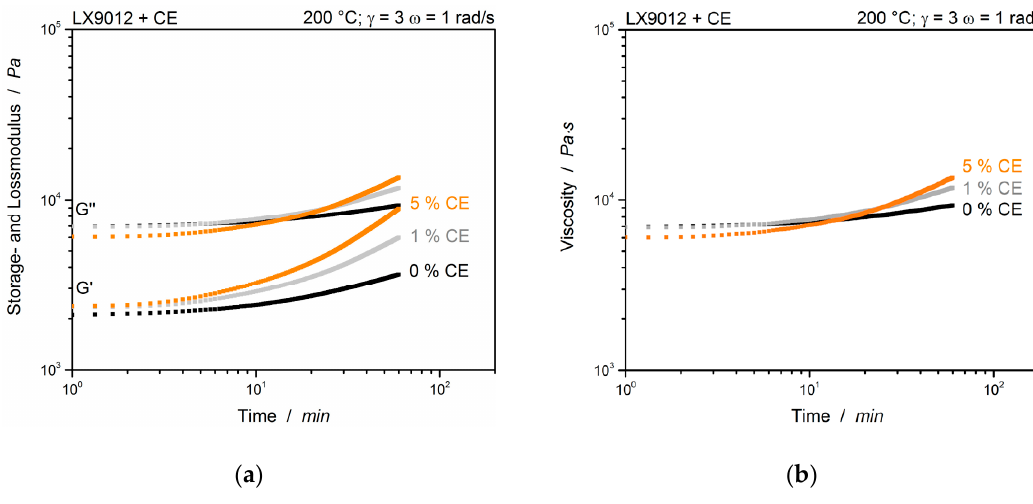
Figure 5. Time sweep of unmodified and chain extender modified LX9012 measured at 200 °C with only 1 rad/s. ( a ) Storage- and loss modulus; ( b ) Viscosity over time.